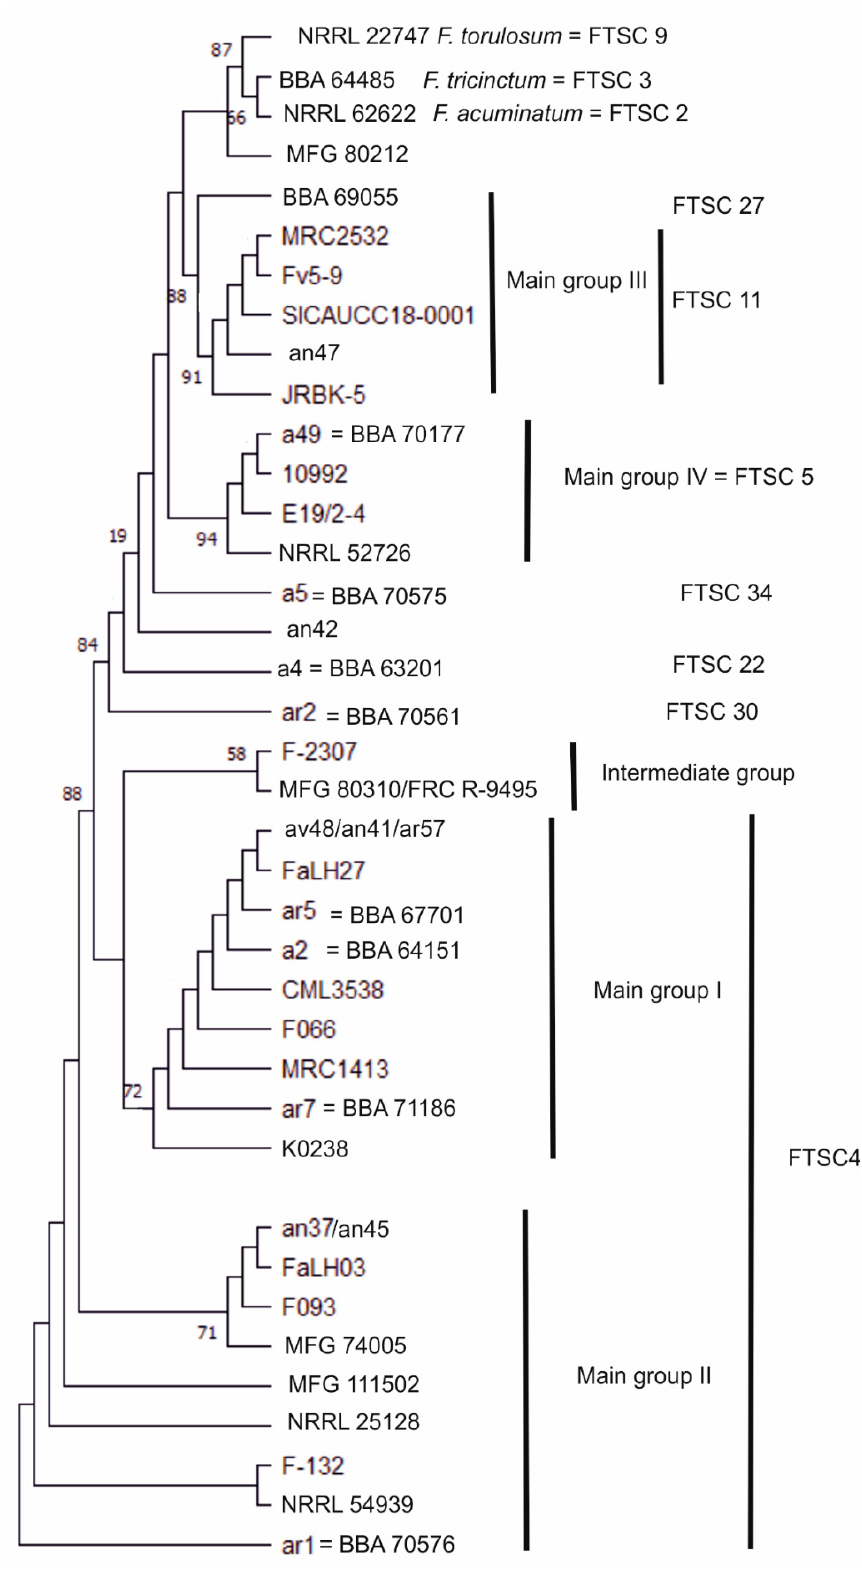
Figure 3. Maximum-parsimony consensus tree of translation elongation factor 1-alpha ( TEF1 ) se- quences, including strains from the work of Stakheev et al. [40] (2016). Bootstrap values are indicated above nodes based on 500 pseudoreplicates of the data. Only branches present in more than 50% of the trees are shown. Fusarium tricinctum and F. acuminatum strains are